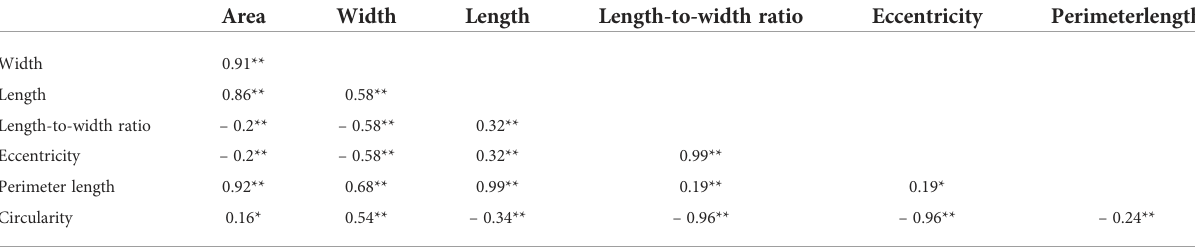
TABLE 3 Pearson ’ s correlation coef fi cients of seed morphology traits using the phenotyping data of F 3